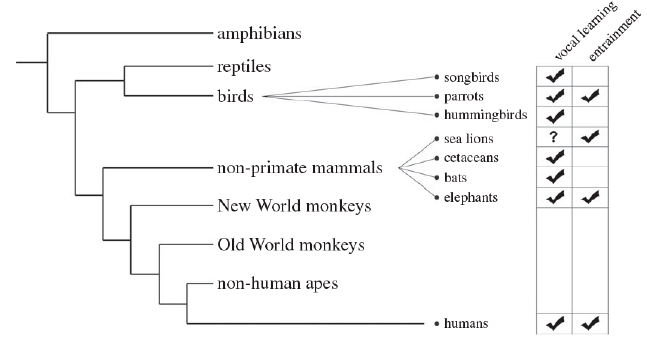
Figure 6. Vocal learning and entrainment in animals according to Hoeschele [14].